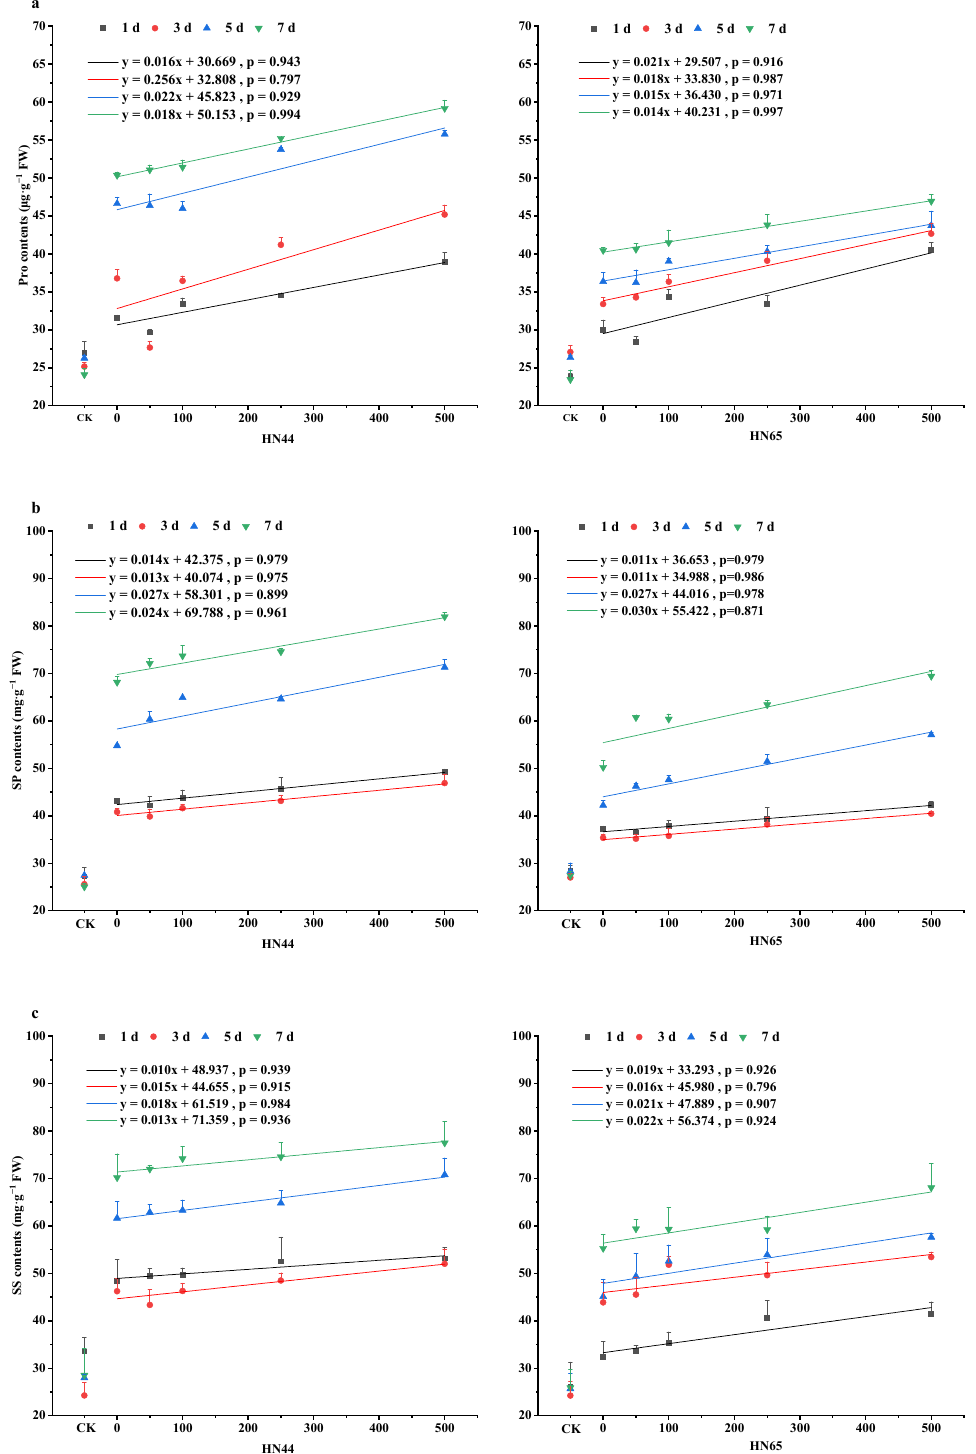
Figure 4. Changes in Pro, SP, and SS content during NO alleviation of drought stress. ( a ) proline (Pro) content, ( b ) soluble protein (SP) content, ( c ) soluble sugar (SS) content. The X -axis, CK represents the control, and the remaining numbers are SNP concentrations sprayed. Values (mean ± SE) are the averages of three independent